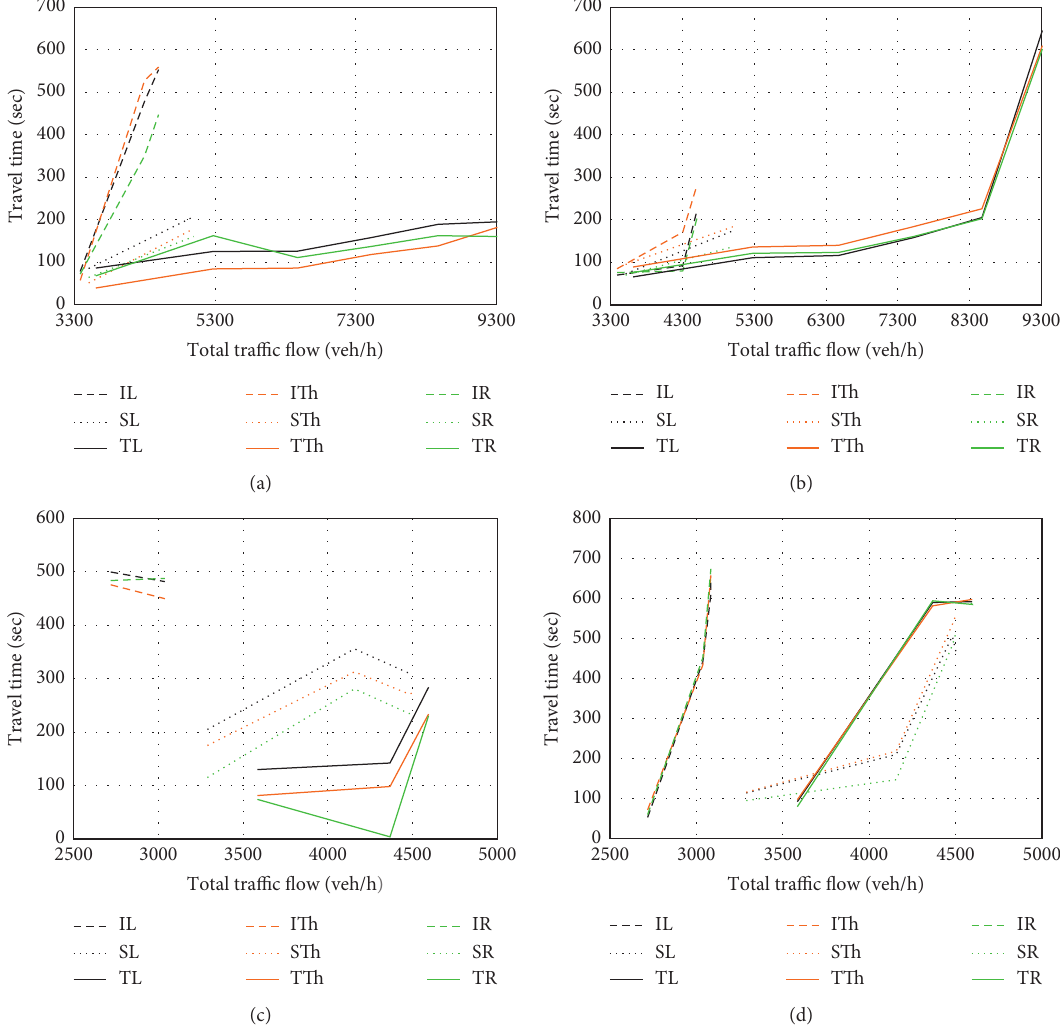
Figure 5: Travel time of the major and minor street movements in unsignalized and signalized intersections. (a) Unsignalized movements of the major street. (b) Unsignalized movements of the minor street. (c) Signalized movements of the major street. (d) Signalized movements of the minor